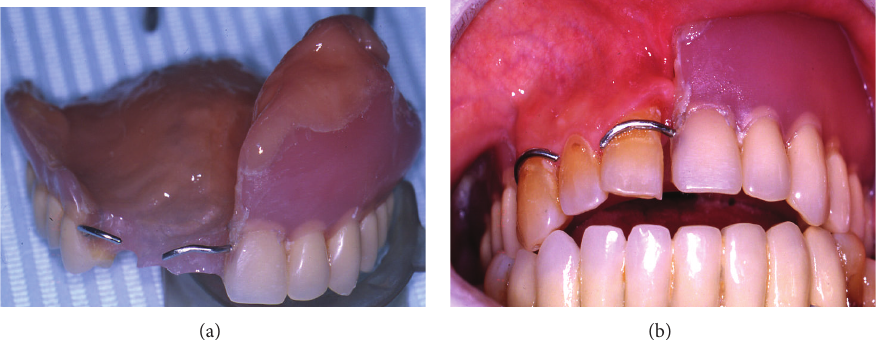
Figure 3: Rehabilitation with social temporary removable prosthesis for aesthetic reasons with good stabilisation of the surgical sites.